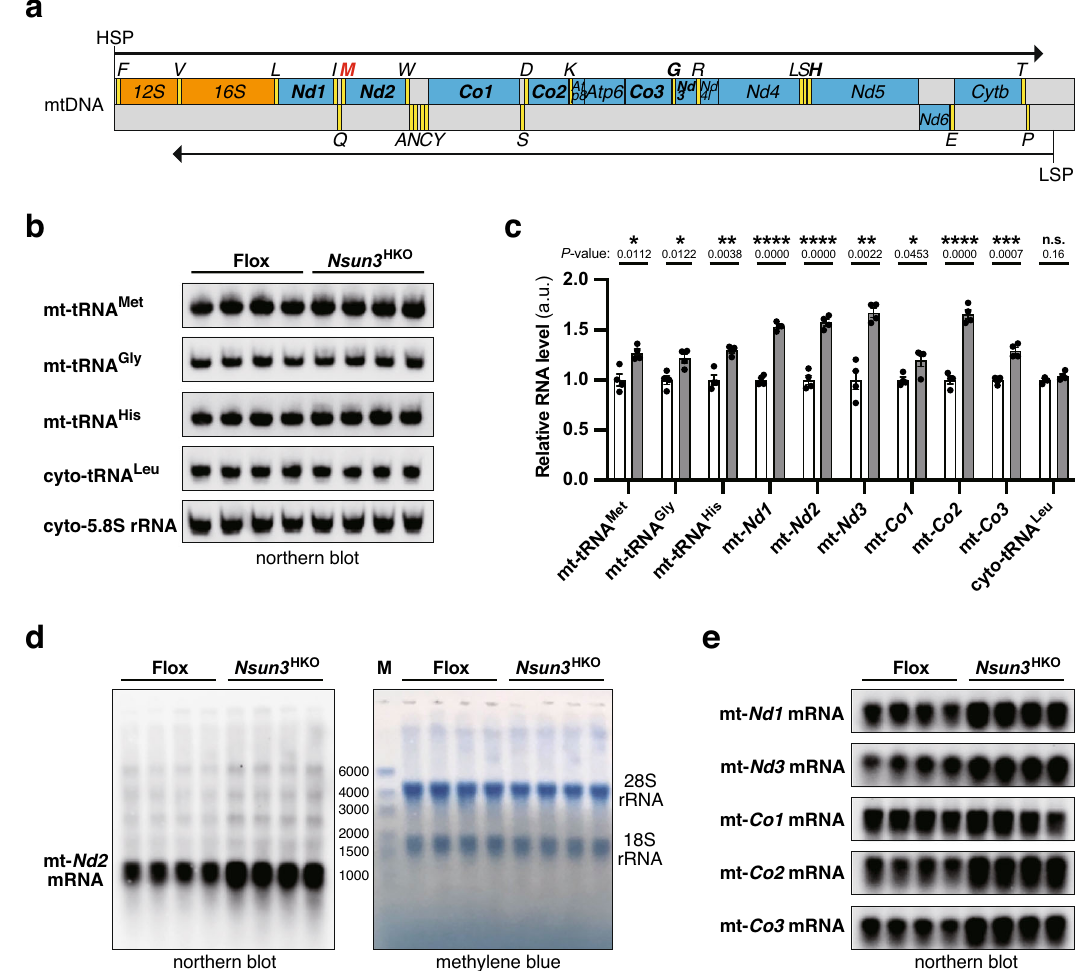
Fig. 5 The steady-state levels of mt-tRNAs and mt-mRNAs in Nsun3 HKO mouse heart. a Schematic of the linearized mtDNA structure consisting of tRNA genes (yellow), protein-coding genes (blue), rRNA genes (orange), and noncoding regions (gray). Polycistronic precursor RNAs are transcribed from the heavy-strand promoter (HSP) and light-strand promoter (LSP), followed by cleavages at the 5 ′ and 3 ′ sides of tRNAs to produce respective RNAs. The mt-tRNA Met gene is indicated in red, and genes encoding northern blotted RNAs are indicated in bold letters. b Northern blot analysis of heart tRNAs from 14-week-old, n = 4 Flox and Nsun3 HKO mice. Cytoplasmic 5.8 S rRNA is shown as a loading control, and cytoplasmic tRNA Leu CAA is shown as a comparison to mt-tRNAs. c Quanti fi cation of tRNAs in ( b ) and mt-mRNAs in ( d ) and ( e ). tRNA was normalized by 5.8 S rRNA, and mRNA was normalized by 28 S rRNA. Means ± s.e.m. from n = 4 Flox and Nsun3 HKO mice. **** P < 0.0001, *** P < 0.001, ** P < 0.01, and * P < 0.05 by Welch ’ s t -test. d Northern blot analysis of heart mt- Nd2 mRNA from the same mice used in tRNA analysis. Mature mt- Nd2 mRNA is 1038 nt plus poly(A) tail of up to 50 nt. The methylene blue-stained membrane used for the mt- Nd2 mRNA northern blot is shown on the right to monitor RNA transfer. M indicates size marker. e Northern blot analysis of heart mt-mRNAs from the same mice as in the above analyses. All of the mtDNA-encoded complex IV subunit mRNAs (mt- Co1 , mt- Co2 , and mt- Co3 ) were